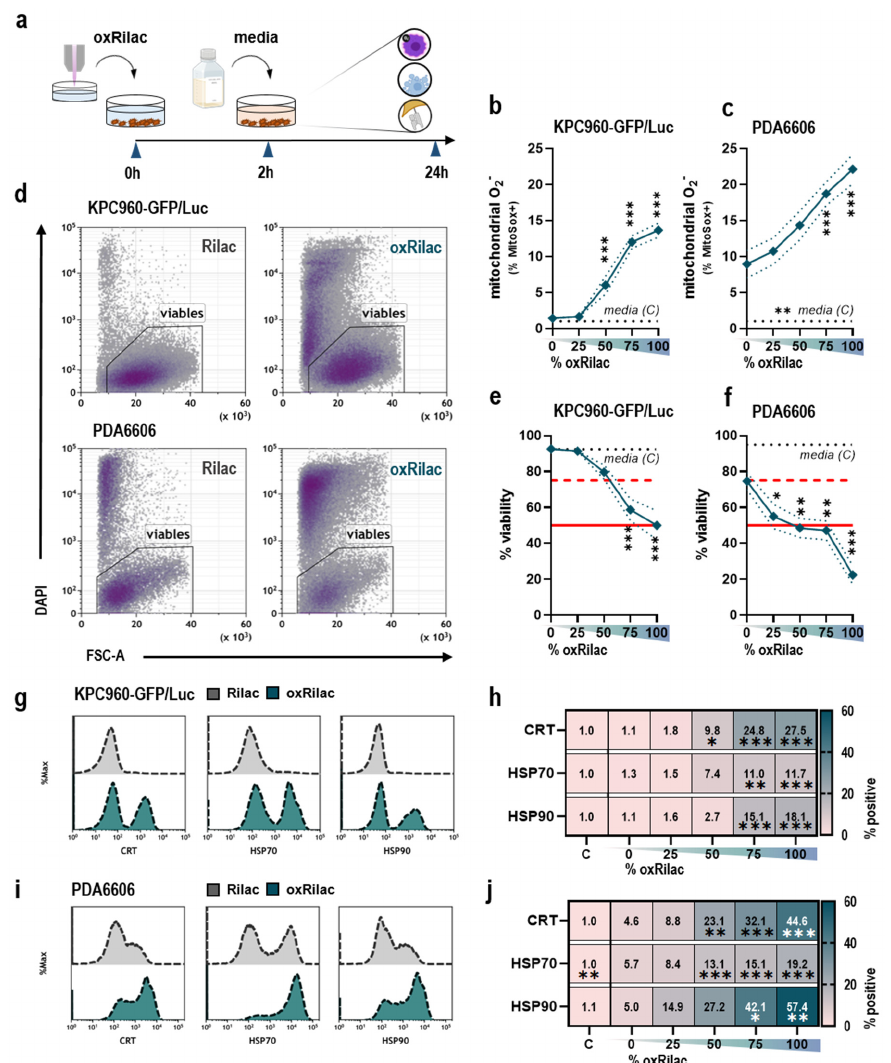
Figure 1. Gas plasma-oxidized Ringer’s lactate induces immunogenic cell death in pancreatic cancer cells. ( a ) A schematic overview of the in vitro experimental procedure with ROS production (purple), cell death (blue), and receptor expression analyses (schematic bubbles on the right) to indicate modes of analysis in this study; ( b , c ) percentage of MitoSOX Red positive ( b ) KPC960-GFP/Luc and ( c ) PDA6606 cells after exposure to serial dilutions of oxRilac solutions; ( d – f ) representative flow cytometry density plots ( d ) of cellular viability after oxRilac exposure and quantification thereof for ( e ) KPC960-GFP/Luc and ( f ) PDA6606 cells (IC 25 (dashed) and IC 50 (continuous) were indicated as red lines for each cell line); ( g ) representative flow cytometry intensity histograms of calreticulin (CRT), heat shock protein (HSP) 70, and HSP90 expression of KPC960-GFP/Luc cells; ( h ) percentage of positive cells; ( i ) representative flow cytometry intensity histograms of (CRT), HSP70 and HSP90 expression of PDA6606 cells; ( j ) percentage of positive cells. Data are mean ± standard error (SEM). Heat maps show medians. Statistical analyses were performed using two-way analyses of variance (* p <0.05; ** p < 0.01; *** p <